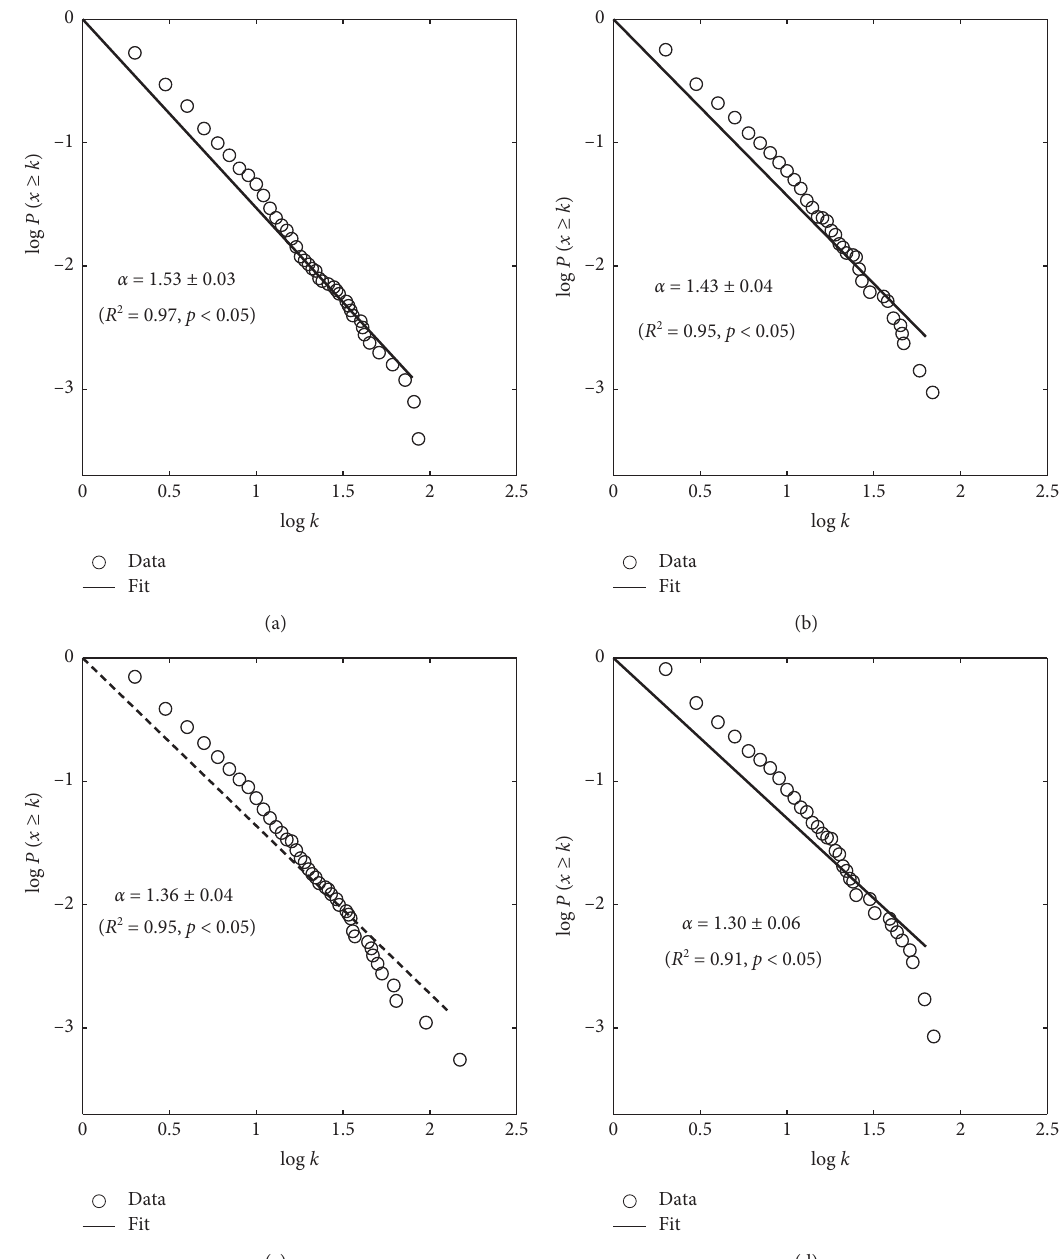
Figure 4: Cumulative degree distributions of the selected urban road networks: (a) S03, (b) S07, (c) S25, and (d)